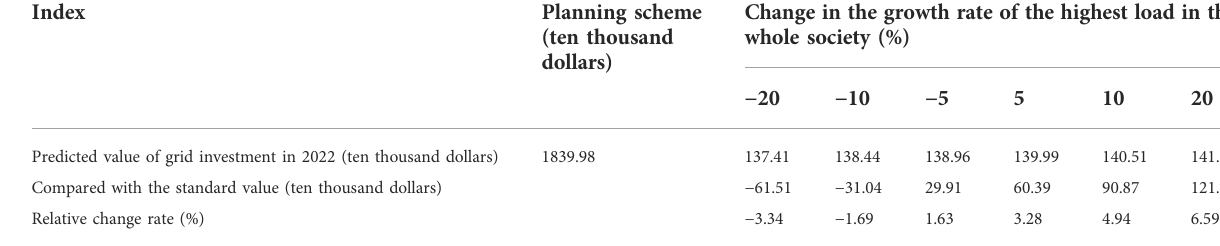
TABLE 5 Sensitivity analysis results of the highest electricity load in the whole society.